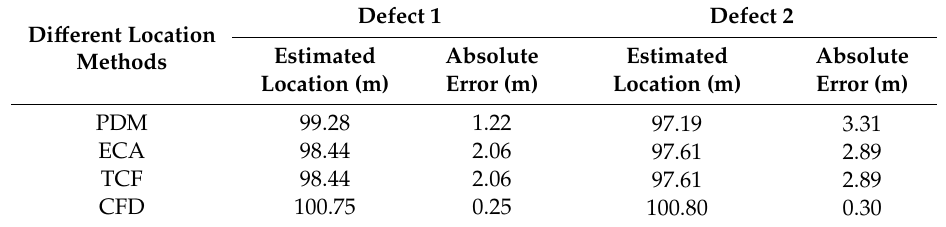
Table 4. Comparison of absolute error values for the di ff erent location methods in measured PD signals.